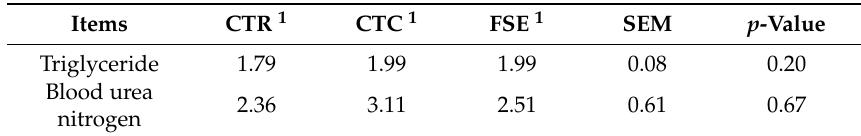
Table 5. E ff ects of Forsythia suspense extract on serum metabolic profile of weaned piglets on day 28 (mmol /